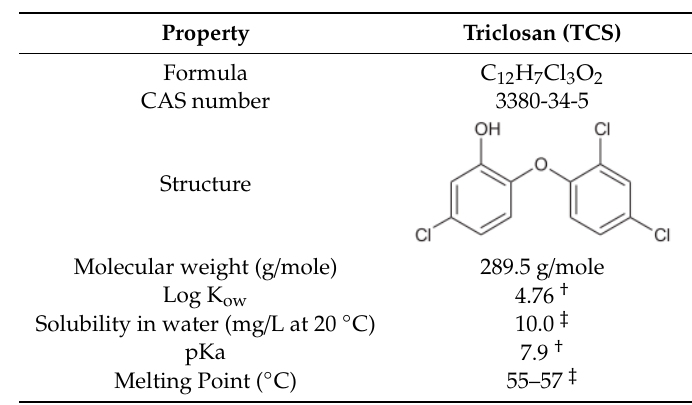
Table 1. Physicochemical properties of triclosan.